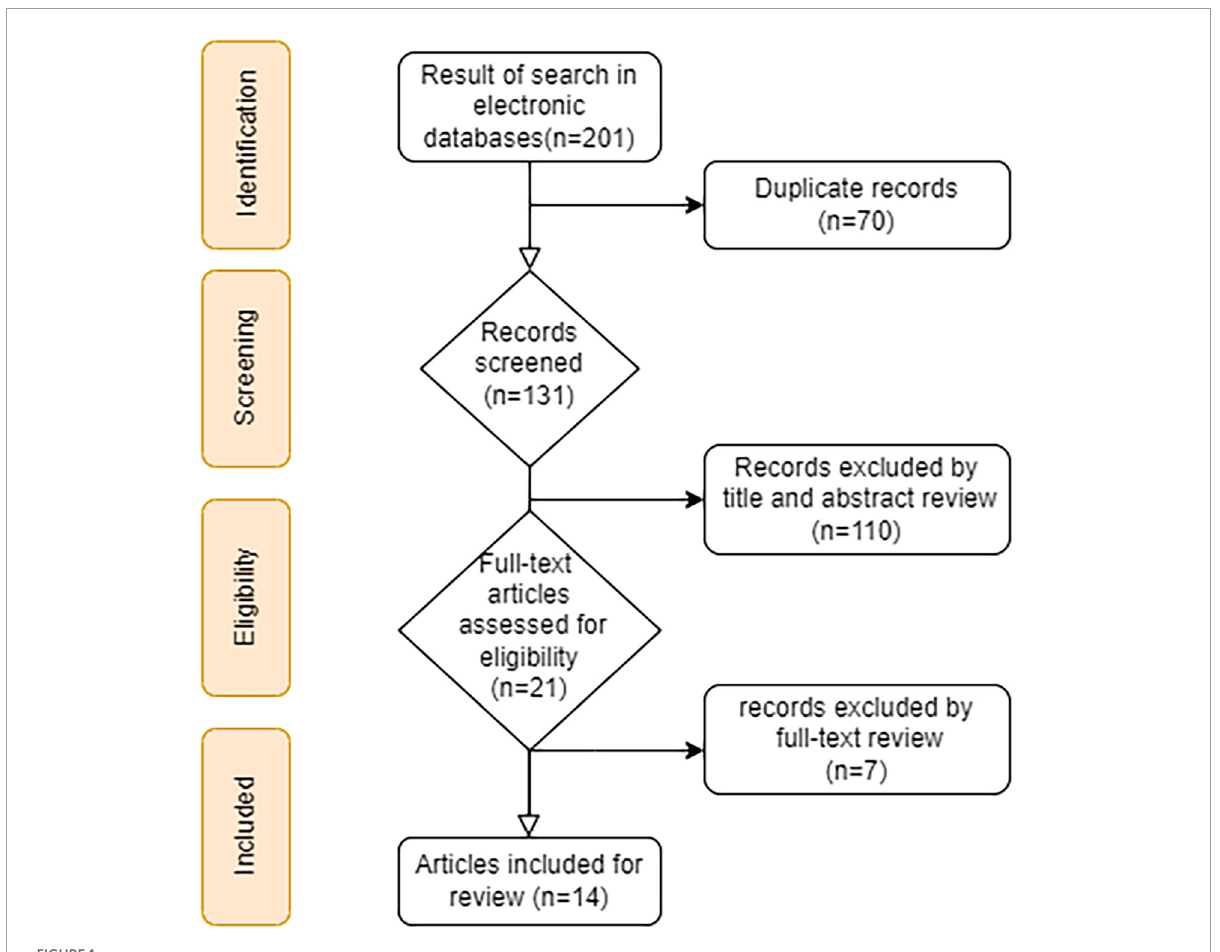
FIGURE1 A flow chart showing the process of literature searching and selecting